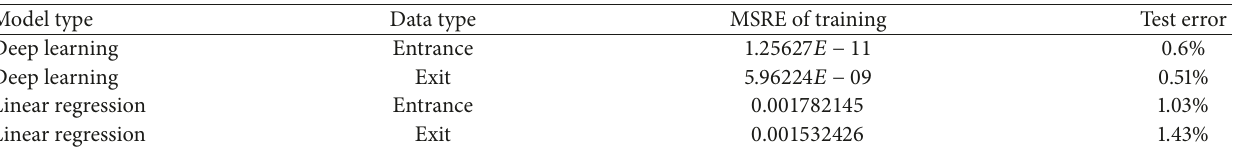
Table 10: Comparison between deep learning model and multiple linear regression (Wuwei station).